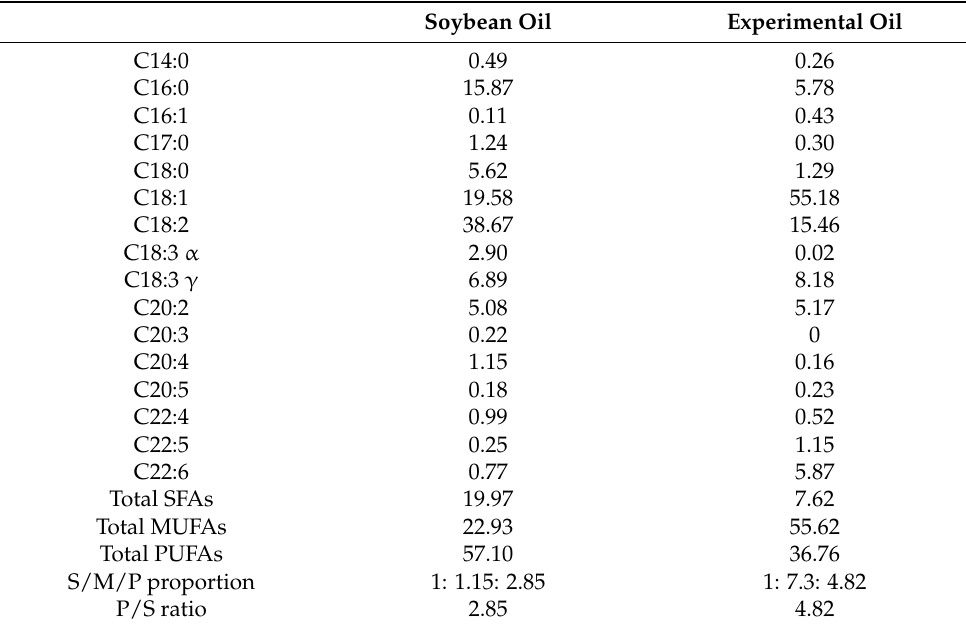
Table 1. Fatty acid compositions (in percent, %) of soybean oil and the experimental oil. Soybean